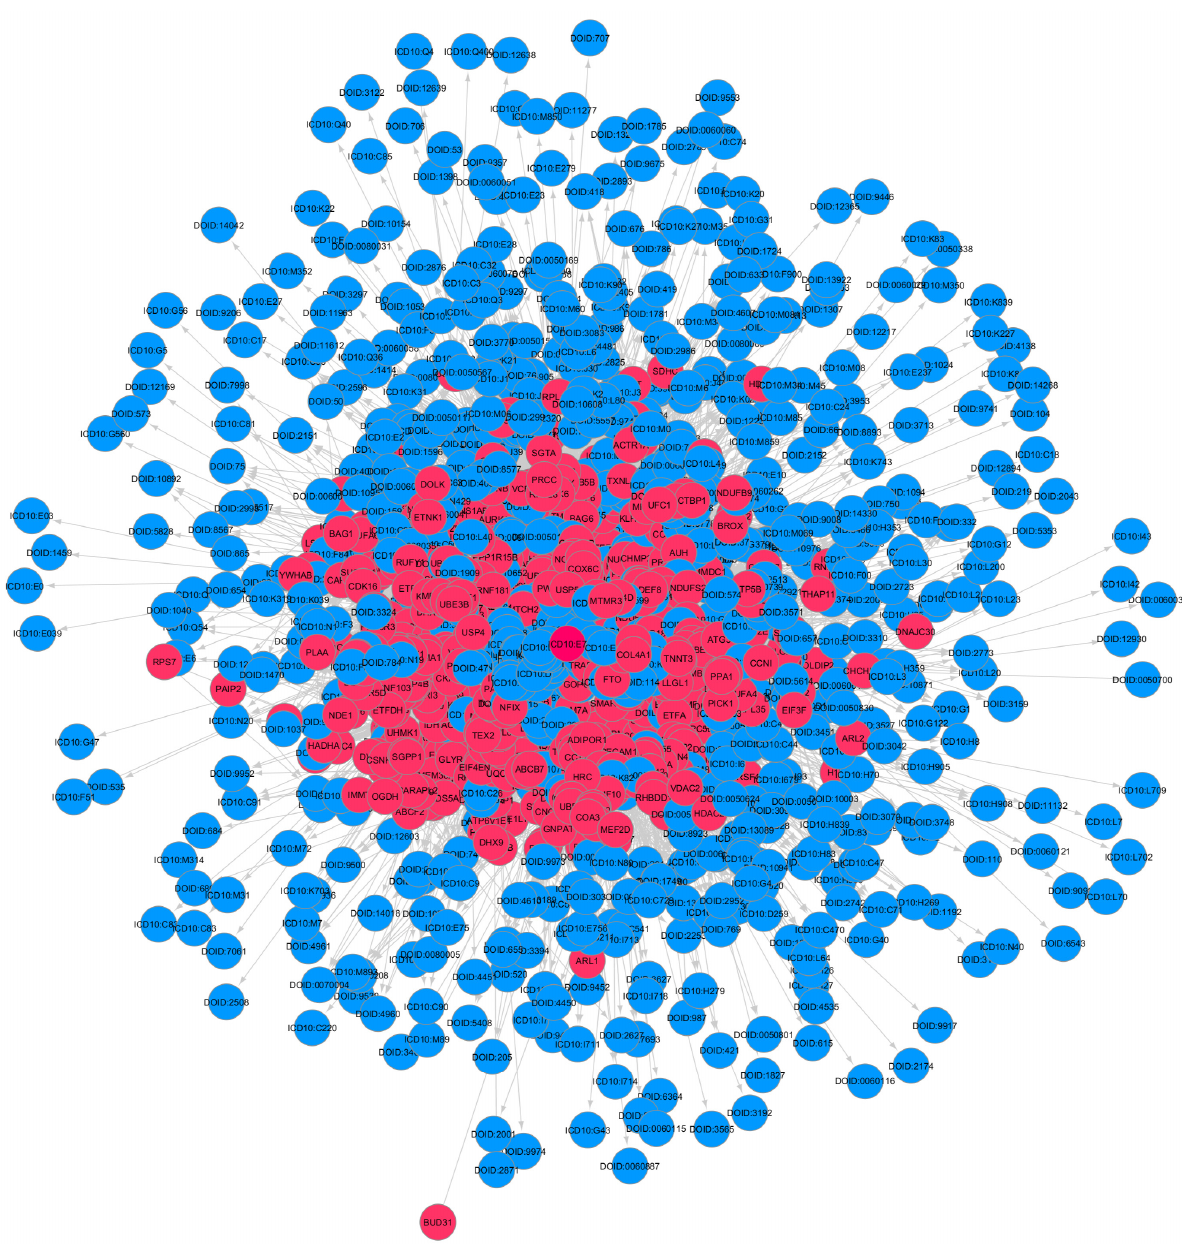
Figure 3. Gene Disease Network (Red nodes–Genes, Blue